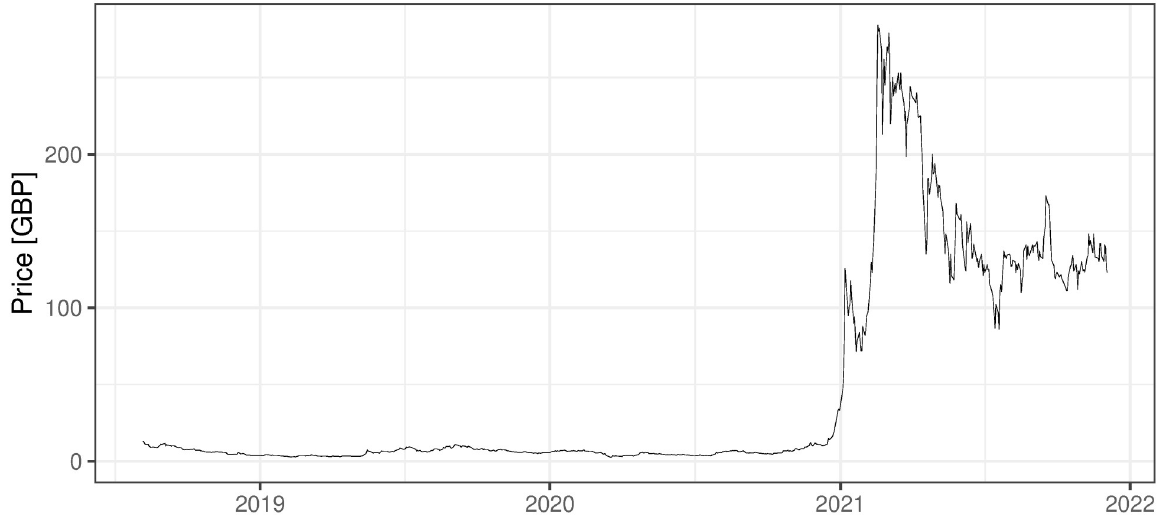
Fig 7. The daily fluctuations of Argo Blockchain prices on LSE. Source: https://query1.finance.yahoo.com/v7/finance/download/ARB.L? period1=1533340800&period2=1639180800&interval=1d&events=history&includeAdjustedClose=true (downloaded on 2021/12/03).